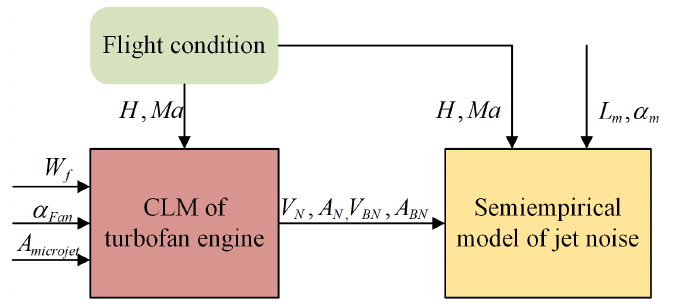
Figure 4. The structure of integrated model of turbofan engine and jet noise.